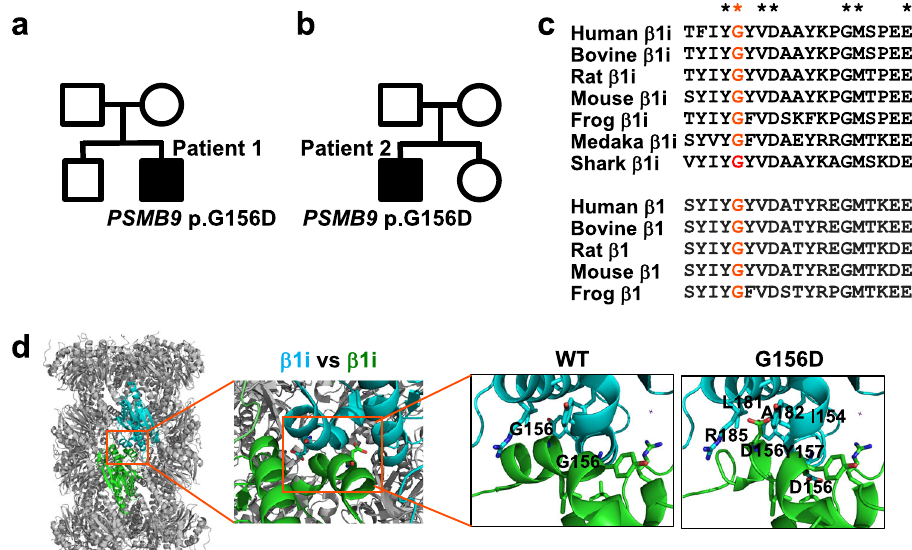
Fig. 2 The heterozygous PSMB9 G156D variant. a , b Pedigrees of patient 1 ( a ) and patient 2 ( b ). c Multiple alignments of PSMB9 ( β 1i) and PSMB6 ( β 1) in various species. Conserved amino acids among all these species are indicated by asterisks. G156 in murine PSMB9 and the corresponding amino acids are indicated in red. d Structures of wild type and PSMB9 G156D mutant of 20S proteasome. Structural models of PSMB9 G156D were created from the β 1i- subunit structure [Protein Data Bank (PDB) ID code 3UNH]. Overall structure of 20S is shown as a ribbon model. β 1i subunits are shown as green and cyan. D156 and some of the potential interacting residues of PSMB9 G156D mutant are shown in stick representation (green and